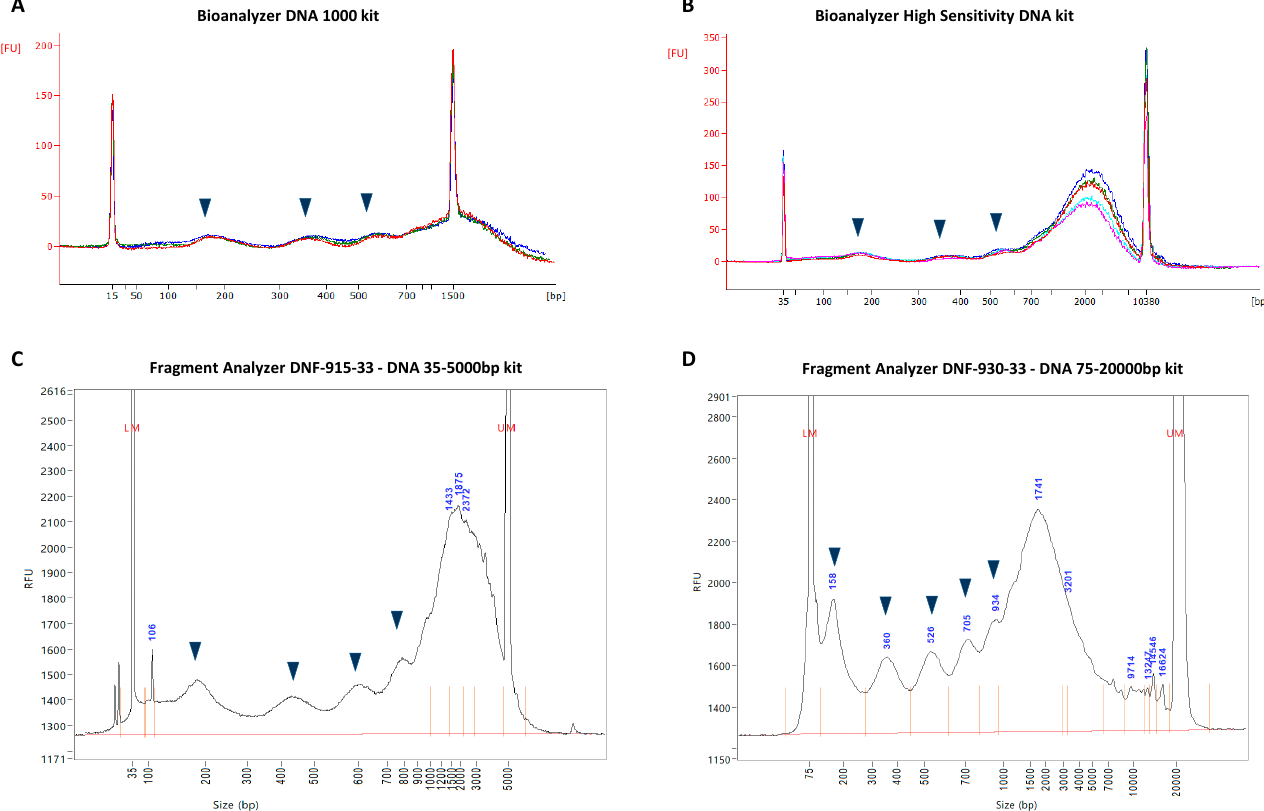
Figure 1. Size profiles of cell-free DNA (cfDNA) isolated from cell culture supernatant. CfDNA was directly isolated from the cell culture supernatant of a human bone osteosarcoma (143B) cell line and analyzed by four different automated microfluidic capillary electrophoresis assays of increasing sensitivity and resolution, including the ( A ) Bioanalyzer DNA 1000 kit; ( B ) Bioanalyzer HS DNA kit; ( C ) FA 915 kit; and ( D ) FA 930 kit. In all of the assays, DNA molecules are detected by laser- induced fluorescence, and the relative fluorescence of the upper marker ( y axis) is used to calculate the concentration of differently sized-cfDNA populations within the sample. The size of individual cfDNA molecules ( x axis) is determined by matching their migration times with the migration times of several internal standards of known size. Arrow markers indicate cfDNA populations that correspond to nucleosomal repeats of increasing length. All graphs in this figure are representative of several experimental repeats, i.e., between 2–3 biological repeats and 3–5 technical repeats (see Supplementary Figures S1–S29 for all